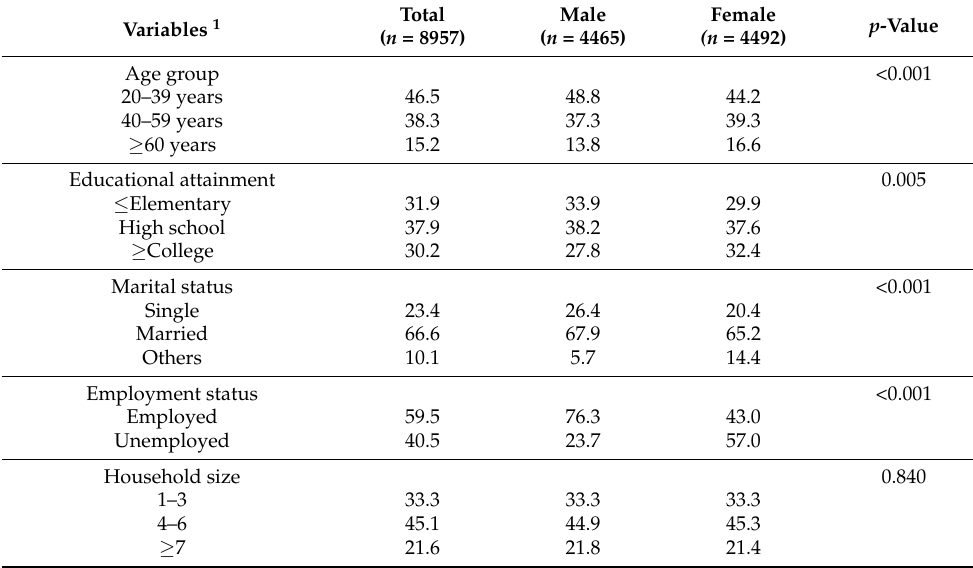
Table 1. Characteristics of the participants according to